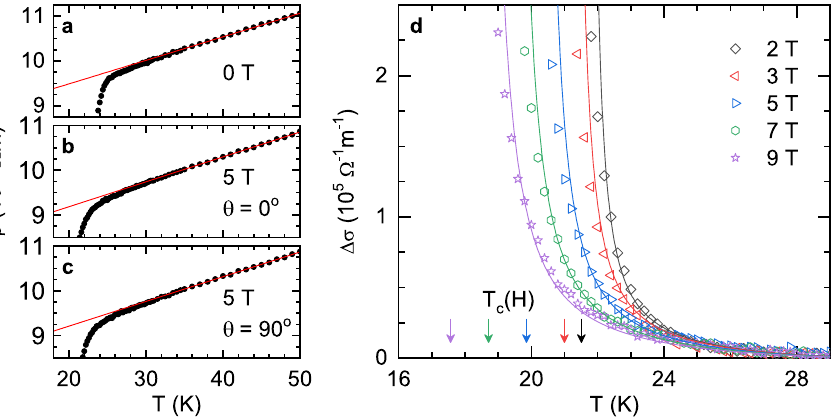
Figure 2. ( a – c ) Some examples (for different H amplitudes and orientations) of the in-plane resistivity temperature dependence well above T c . The normal-state backgrounds (red lines) were determined by linear fits above 35 K ( ∼ 1.5 T c ), where fluctuation effects are negligible. ( d ) Temperature dependence of the fluctuation conductivity under different magnetic fields, applied perpendicular to the crystal ab layers ( θ = 0 ). The lines are the best fit of Eq. (3) to the data between 2 and 9 T. The arrows indicate T c ( H ) = T c ( 1 − H / H ⊥ c 2 ( 0 )) for the magnetic fields used in the